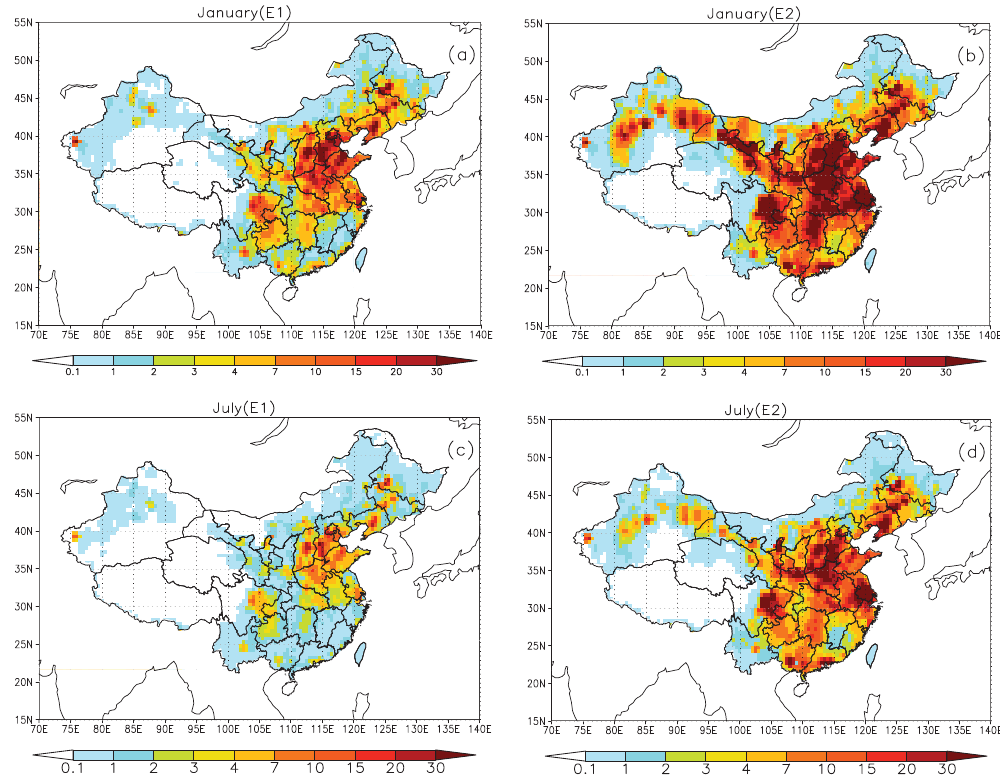
Figure 6. BC emissions from China inversed by 27 observation sites (units: µgm − 2 s − 1 ): (a) bottom-up emissions E1 for January; (b) in- versed emissions E2 for January; (c) bottom-up emissions E1 for July; (d) inverse emissions E2 for